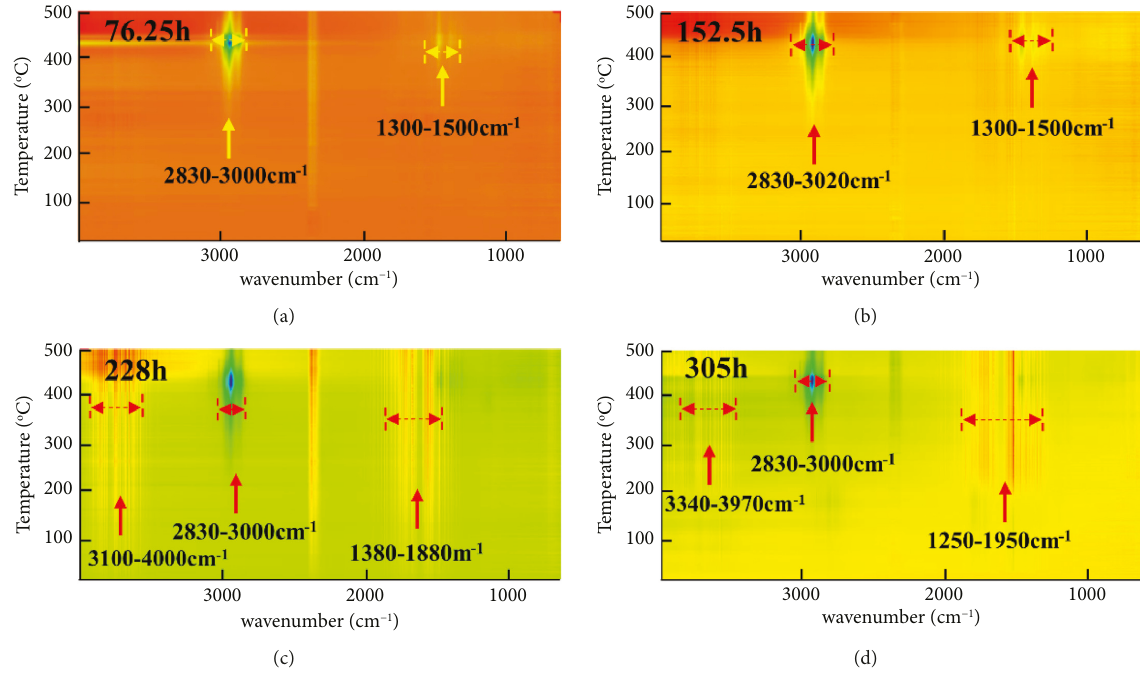
Figure 13: 2D spectrogram of 70# base modified asphalt at different UV aging stages. (a) 76.25h-2D. (b) 152.5h-2D. (c) 228h-2D. (d) 305h-2D.